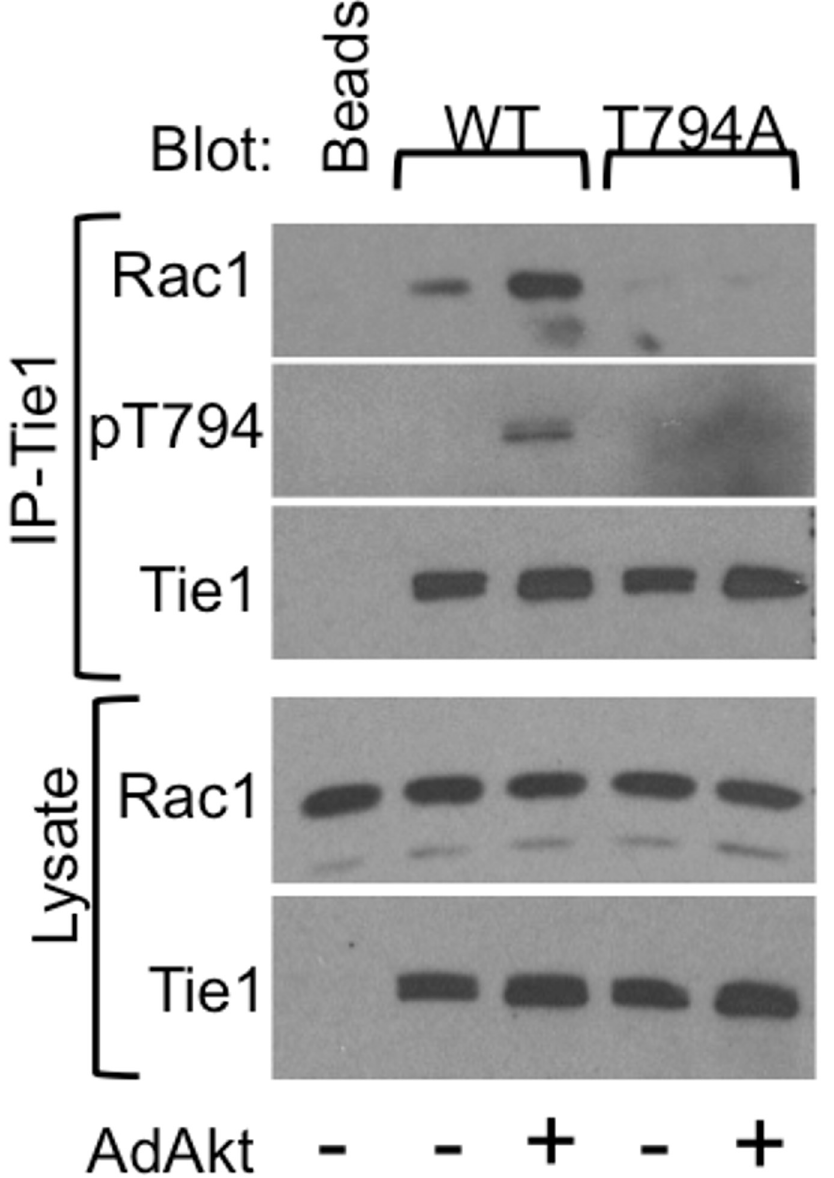
Fig 4. Rac1 association with Tie1 is enhanced by T794 phosphorylation. HUVECs were infected with adenoviruses encoding Tie1-WT and -T794A, with or without AdAkt, and Tie1 was immunoprecipitated (IP) from cell lysates and western blotted as indicated. Whole cell lysates were blotted for total Tie1 and